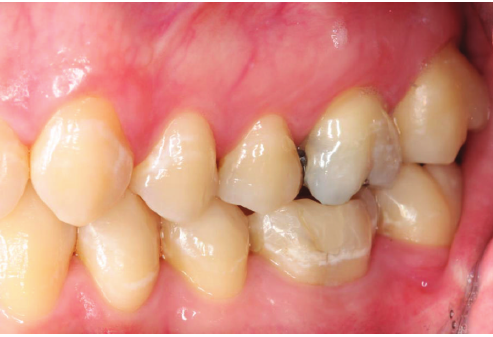
Figure 1: An intraoral clinical examination of the mandible did not reveal macroscopically detectable pathologies.